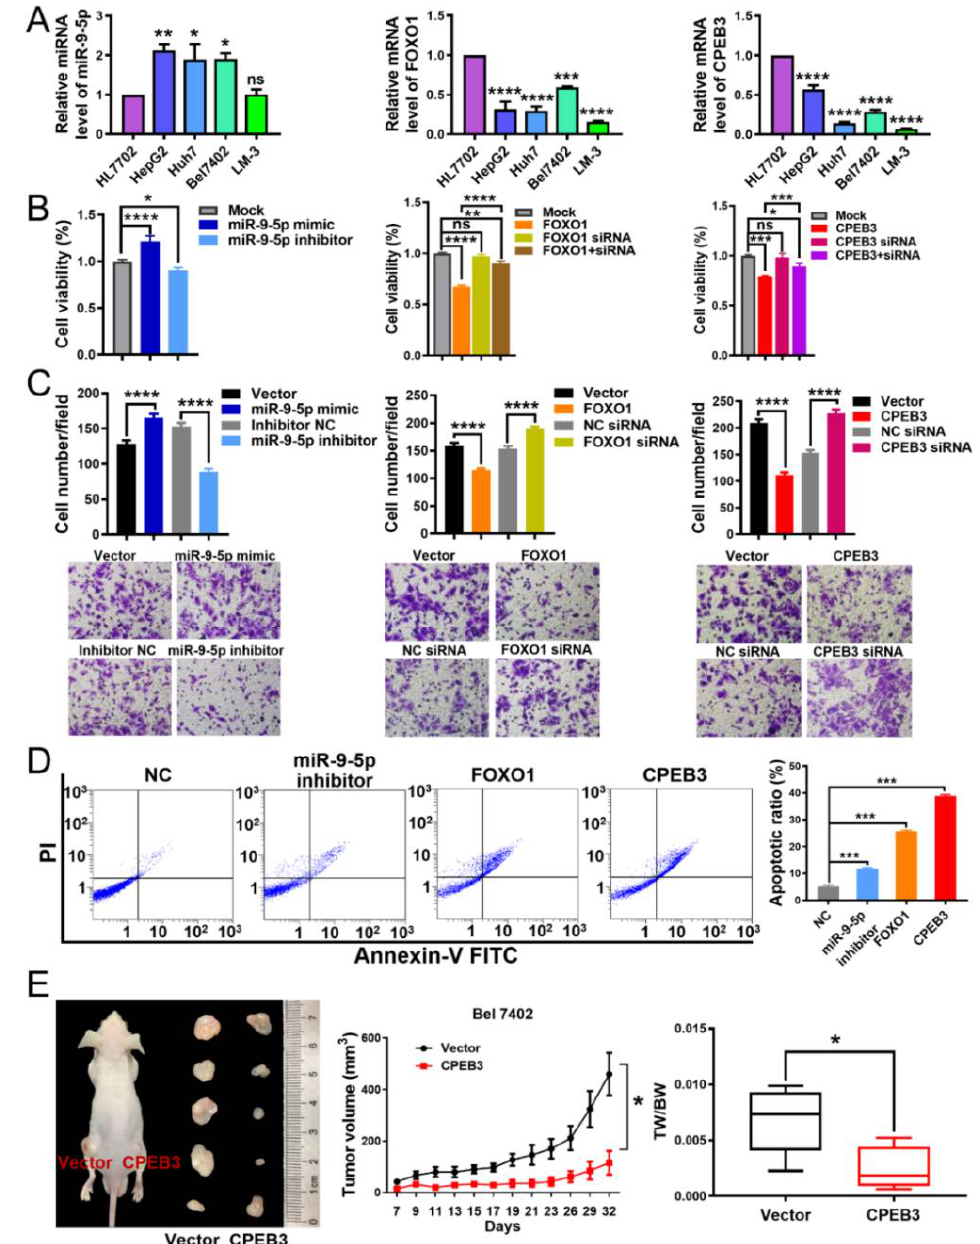
Figure 2. miR-9-5p promotes the growth of HCC cells in vitro; FOXO1 and CPEB3 inhibit cell growth. ( A ) qRT-PCR expression analysis of miR-9-5p, FOXO1 and CPEB3 expression in liver (HL7702) and HCC cell lines. Gene expression levels in cell lines were calculated as relative expression to HL7702 (normalized to 1). Non-parametric one-way ANOVA with Dunnett’s multiple comparison post hoc test was performed. Mean ± s.e.m., n = 3/group. Unless otherwise stated, the subsequent tests were carried out in the same way. ( B ) Cell viability of Bel7402 cells after transfection with Mock (control cells group), miR-9-5p mimics, inhibitor as indicated (left); Transfected with Mock, FOXO1 siRNA or FOXO1 vector with or without siRNA (middle); Transfected with Mock, CPEB3 siRNA or CPEB3 vector with or without siRNA (right). Cell viability in treatment groups was calculated as relative values to Mock (normalized to 1). n = 4/group in cell viability analyses, while n = 9/group in cell number analyses. ( C ) Transwell assays of cellular invasion after transfection with miR-9-5p mimic or its inhibitor, FOXO1 or FOXO1 -specific small interference RNA (siFOXO1), and CPEB3 or CPEB3 -specific small interference RNA (siCPEB3) in Bel7402 cells. Representative images (bottom) and quantification of 10 randomly selected fields (top) are shown. ( D ) Apoptosis in Bel7402 cells induced by miR-9-5p inhibitor, FOXO1, and CPEB3 was detected using flow cytom- etry. n = 3/group. ( E ) The in vivo effect of CPEB3 was evaluated in xenograft mouse models bearing